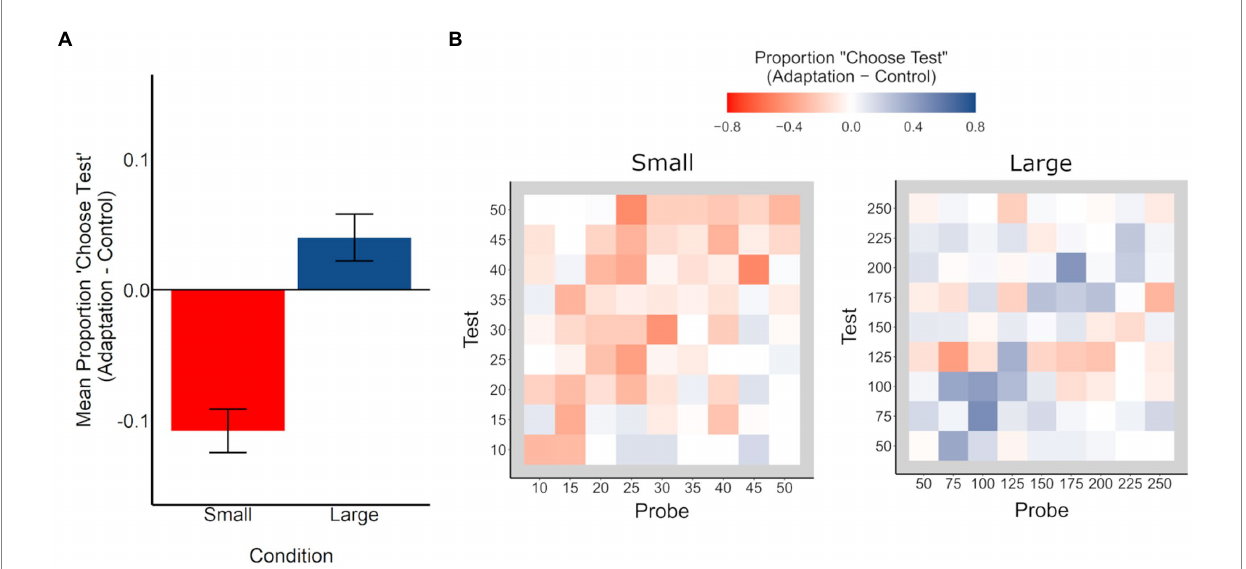
FIGURE 3 (A) Difference in mean proportion of trials in which participants chose the test stimulus as more numerous (adaptation minus control), for small (red) and large (blue) conditions. Negative values reflect underestimation of the test stimulus (adapted location) in the adaptation condition, relative to the control condition, and positive values reflect overestimation of the test stimulus (adapted location) in the adaptation condition, relative to the control condition. Error bars represent +/ − 1 SE. (B) Difference in mean proportion of trials in which participants chose the test stimulus as more numerous (adaptation minus control) for each test/probe stimulus pair, for small (left) and large (right) conditions. Negative values (red) reflect underestimation of the test stimulus in the adaptation condition relative to the control condition, and positive values (blue) reflect overestimation of the test stimulus in the adaptation condition relative to the control condition. For example, a value of − 0.10 suggests that participants chose the test stimulus as more numerous 10% less often in the adaptation condition than in the control